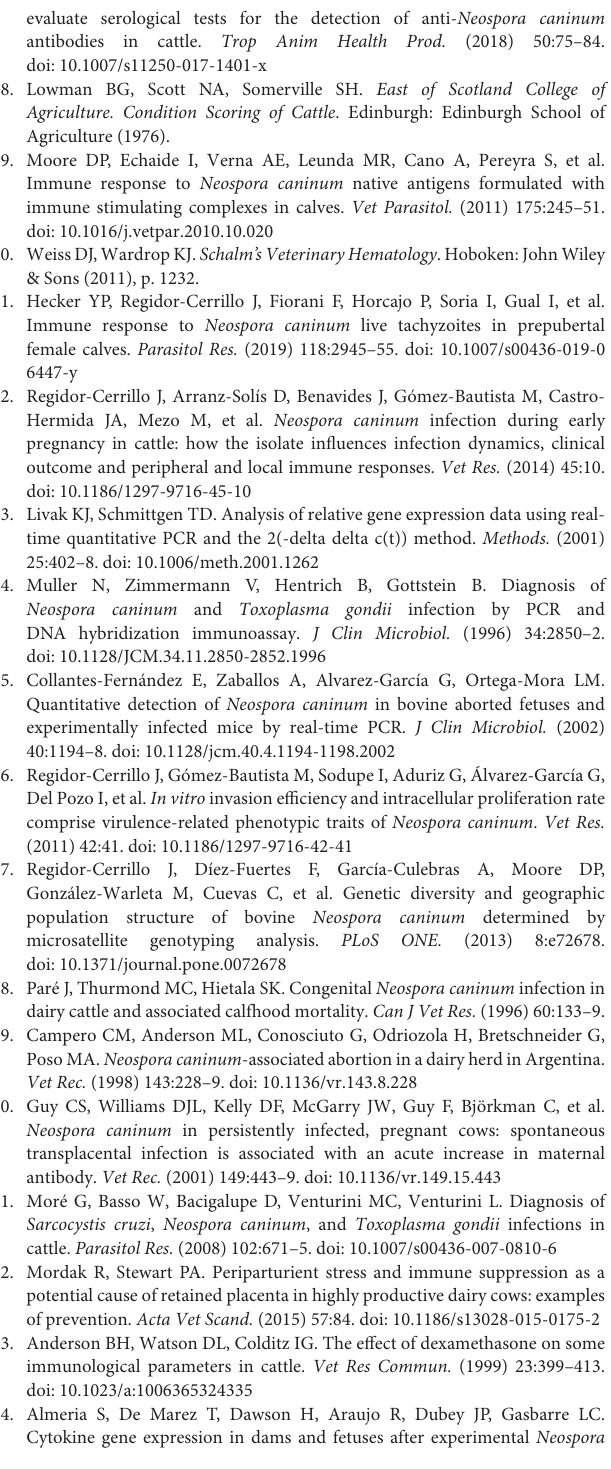
Supplementary Figure 3 | Lymphoplasmacytic infiltrate foci (circle) in placenta from cow #3 from + Preg group (A) . Calcification areas (circles) in placenta from cow #2 from +Preg group (B) . HE stain.